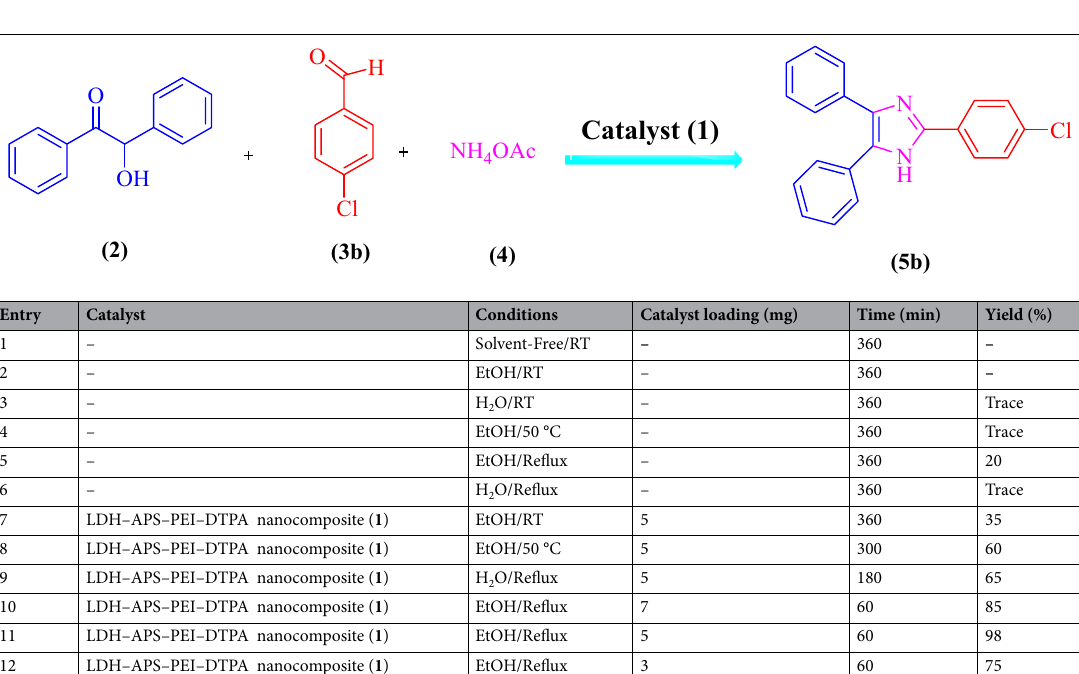
Figure 7. N 2 adsorption–desorption curves for the LDH–APS–PEI–DTPA nanocomposite ( 1 ).